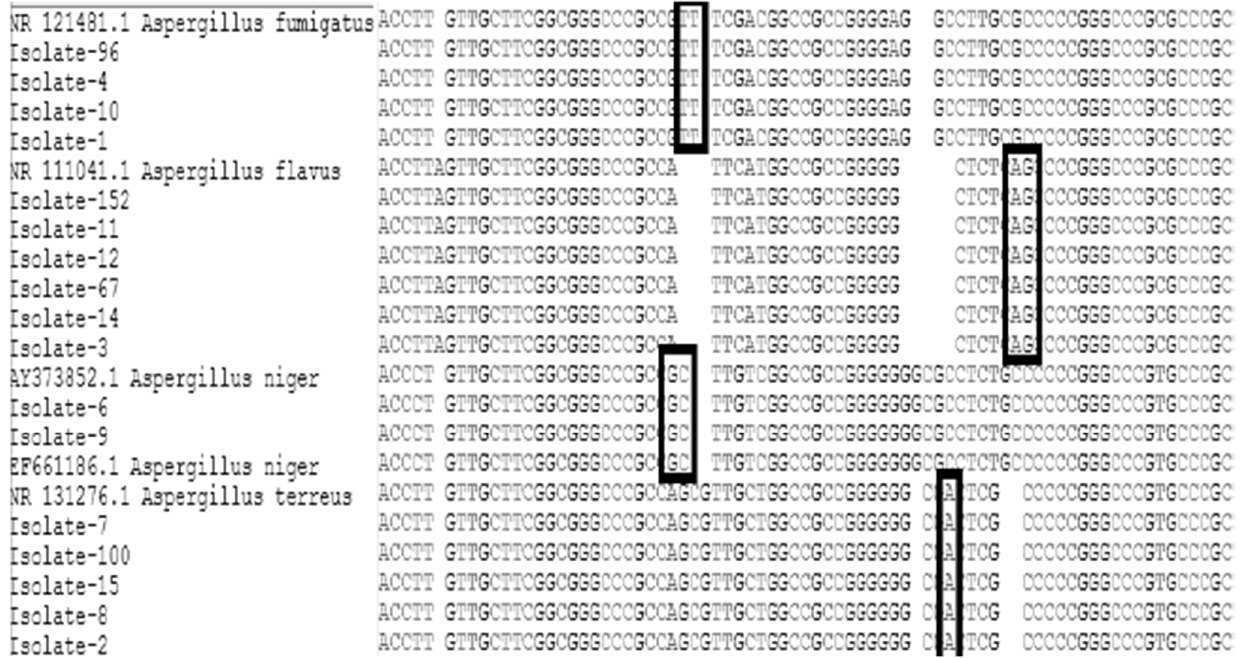
Figure 1. Nucleotide sequence alignment of Aspergillus isolates and reference strains in the gene bank; A. flavus (ATCC 16883), A. fumigatus (ATCC 1022), A. niger (ATCC 16888), A. terreus (ATCC 1012). The alignment consists of the 3 ′ end of the 18S ribosomal DNA (rDNA) gene (which contains the ITS 1 primer site), the entire ITS 1 region, the whole ITS2 region, and the 5 ′ end of the 28S rDNA gene (which contains the ITS 4 primer site). Black boxes indicated species-specific nucleotides.